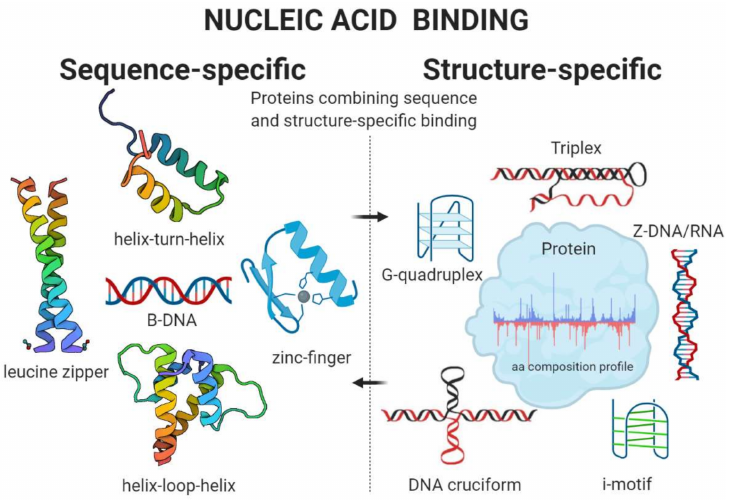
Figure 2. Types of nucleic acid-binding. The nucleic acid-binding mechanism can be basically divided into two main categories—sequence and structure-specific binding. (Left) Sequence-specific binding proteins recognize the variety of known DNA/RNA sequences via specific interaction with well-characterized protein motifs (zinc-fingers, helix-loop-helix, leucine zipper, helix-turn-helix, etc.). (Right) Structure-specific binding proteins recognize specific local structure(s) of nucleic acids, e.g., G-quadruplexes, i-motifs, cruciforms, triplexes, Z-DNA, and many others. In fact, it is a very common phenomenon that protein with the sequence-specific binding also prefers local DNA/RNA structure in its binding site or within the near neighborhood (e.g., p53), which is indicated by vertical black dashed line and arrows. Created with